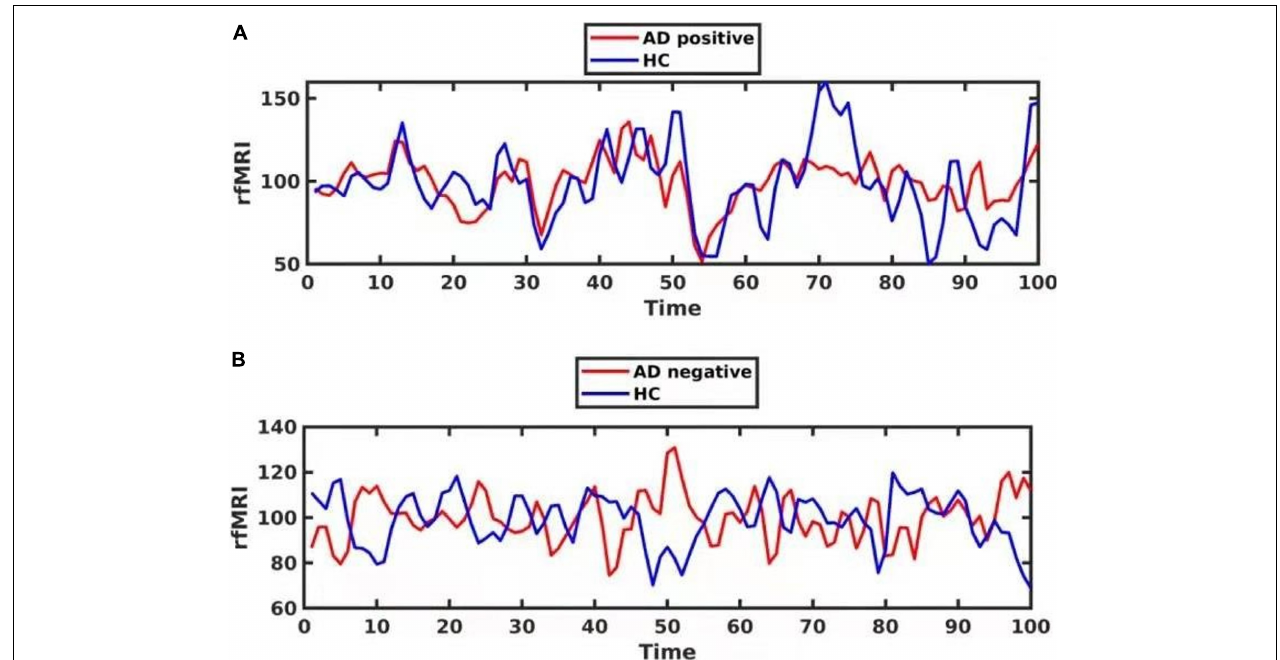
FIGURE 3 | The phase delay of the functional BOLD series for one Alzheimer’s disease (AD) patient with positive functional connectivity (FC) [ (A) , red] and another AD patient with negative FC [ (B) , red]. The FC is between Cluster 1 and Cluster 2. The time series for one healthy control is shown in